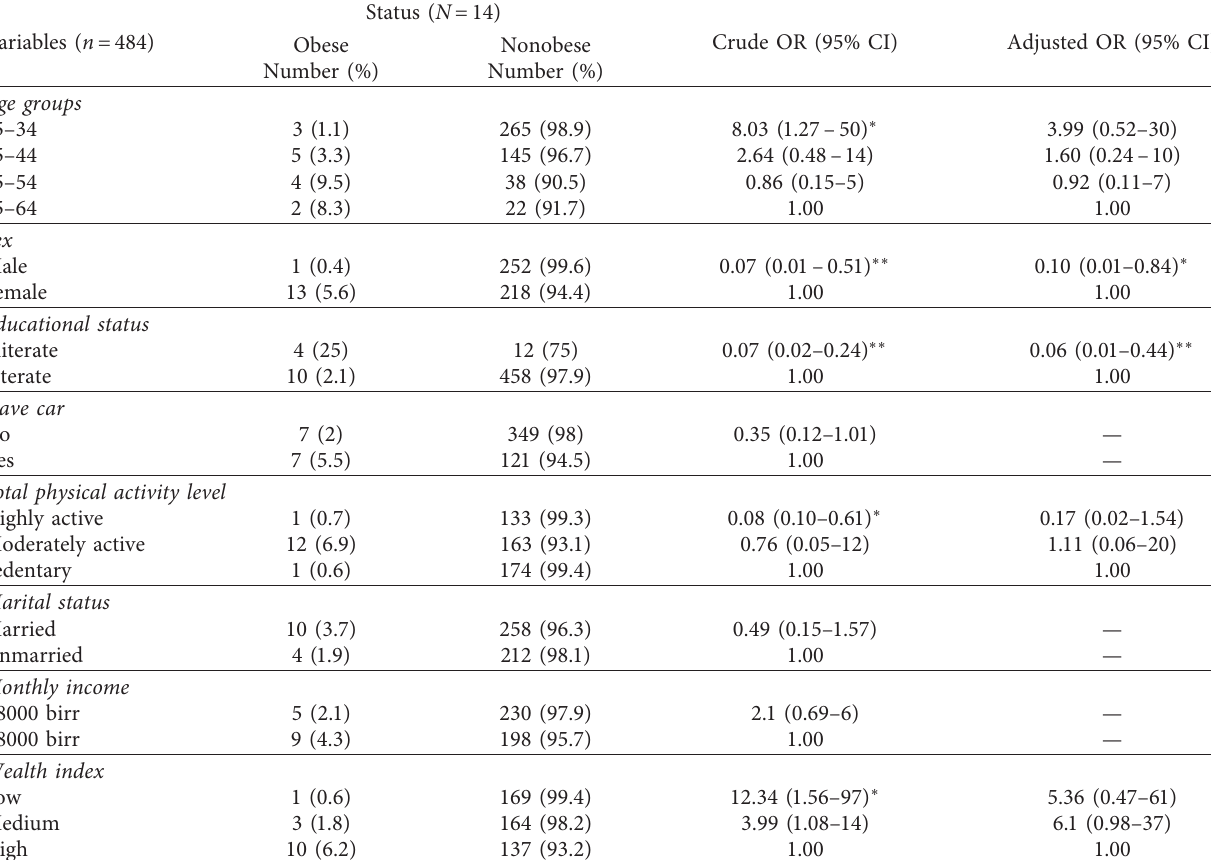
Table 5: Multivariable logistic regression model predicting obesity among adults in Addis Ababa,